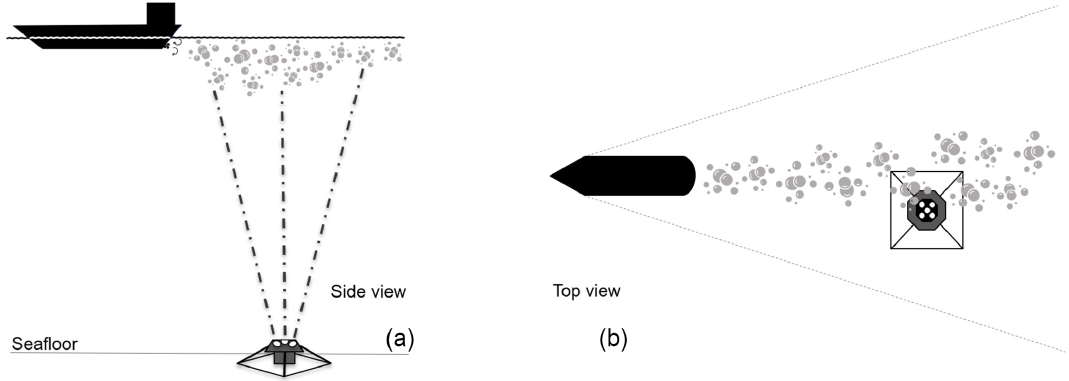
Figure 2. Scheme of instrument deployment, showing (a) the side view with a perspective of the ADCP placed on the seafloor facing upward and recording the turbulent wakes during ship passages and (b) a top-view perspective of the ADCP recording bubbles from a turbulent wake, induced by a ship passing above, but slightly to the side of the